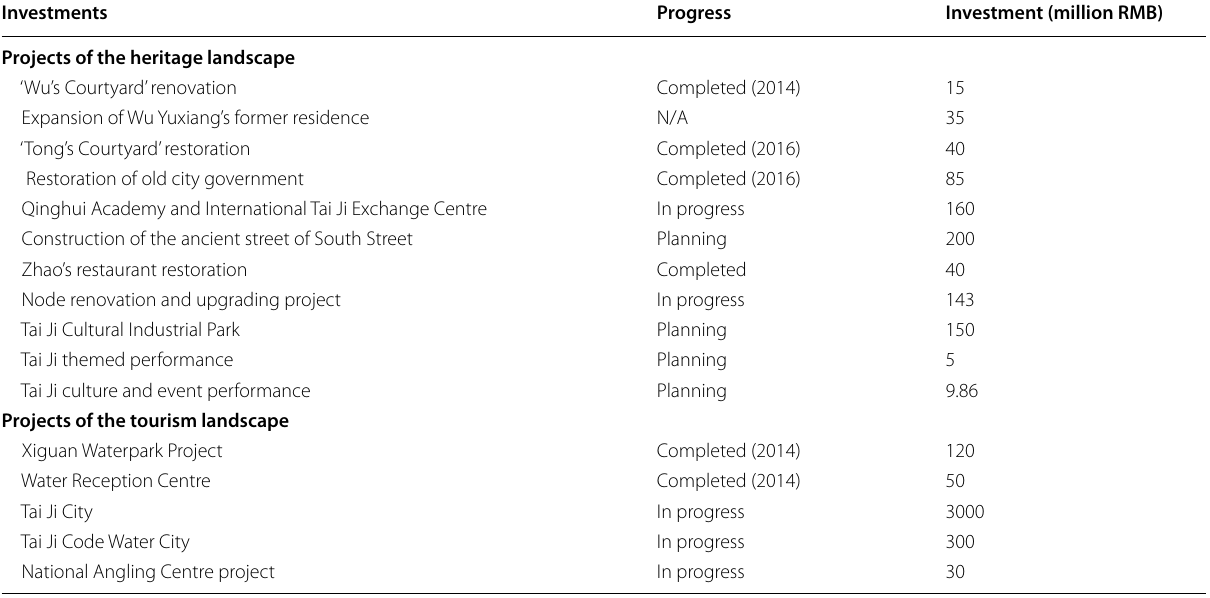
Data Source: Summary of Guangfu Ancient City tourism development,